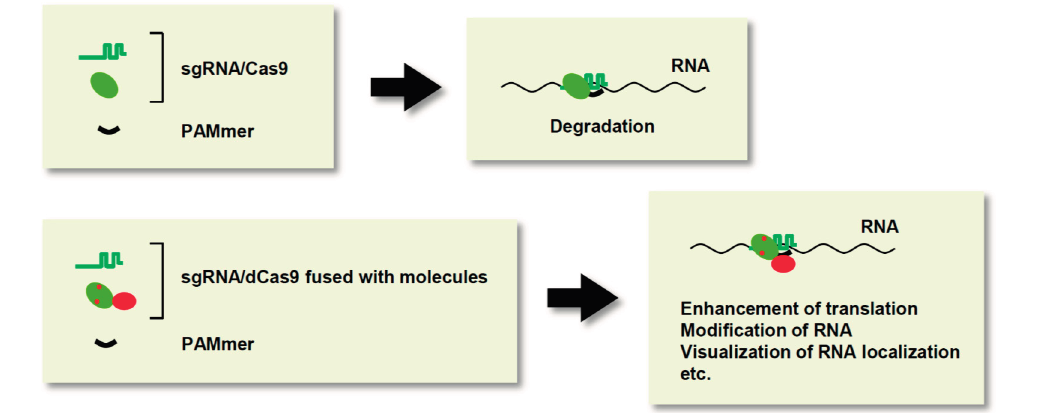
Figure 4. CRISPR/Cas-mediated analysis of RNA. The CRISPR/Cas system can